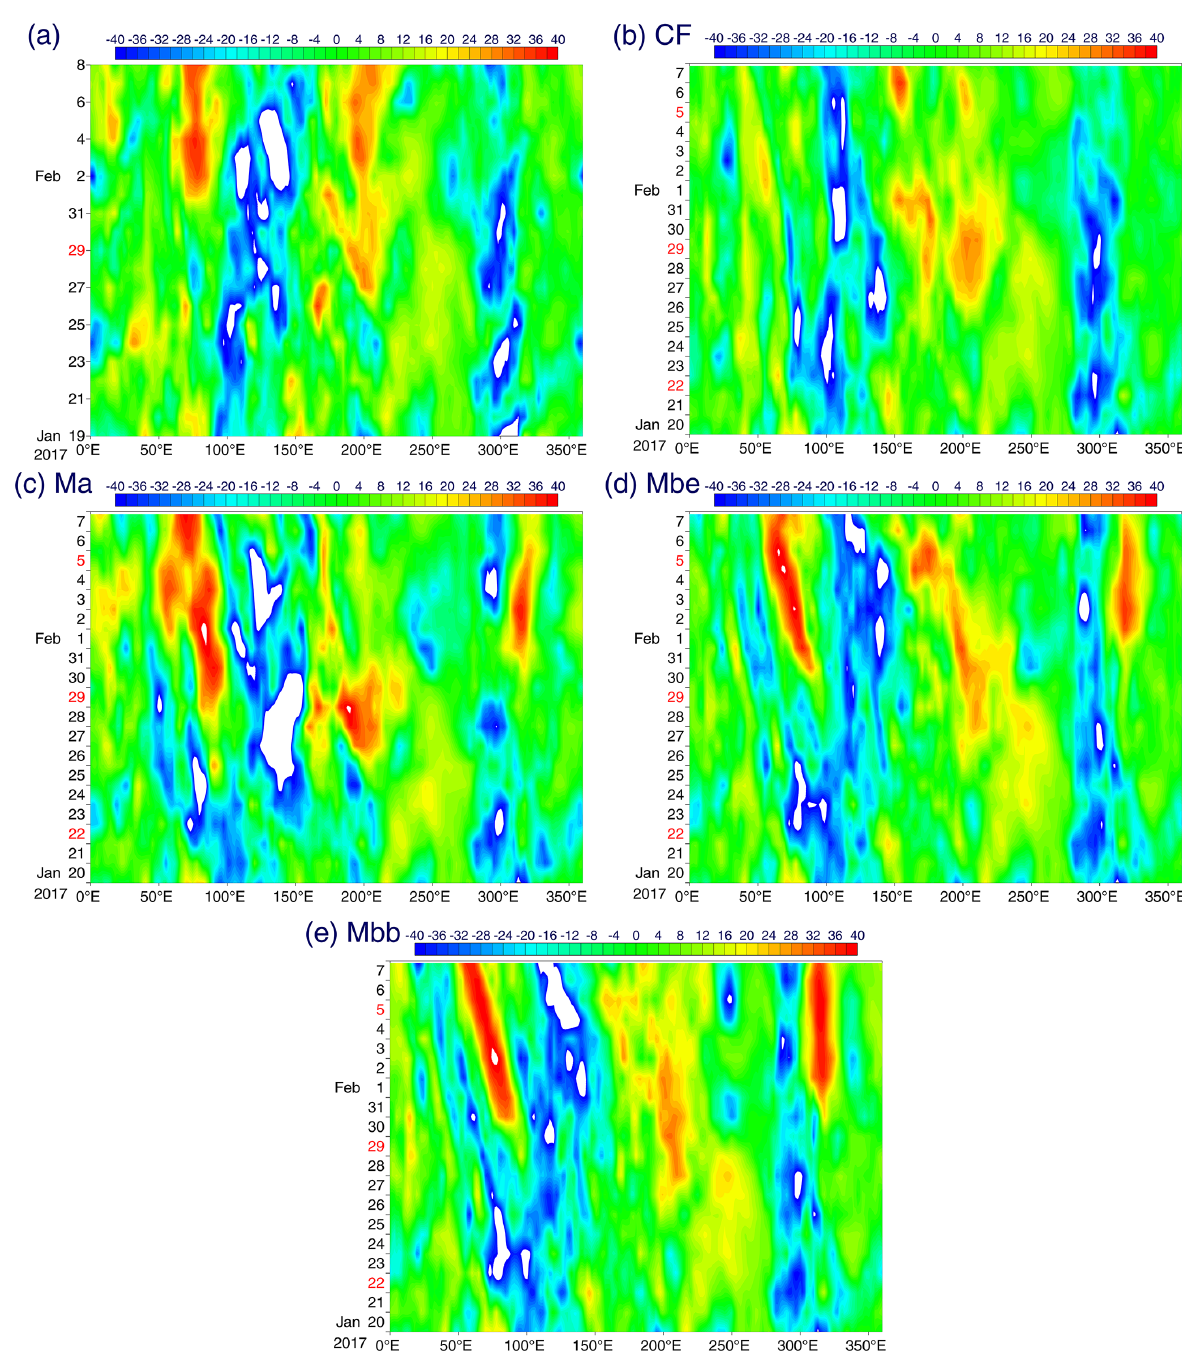
Figure 2. Time–longitude sections averaged over 15 ◦ S–15 ◦ N of OLR for the standard 20d forecast case: (a) analysis, (b) CF, (c) Ma, (d) Mbe and (e)